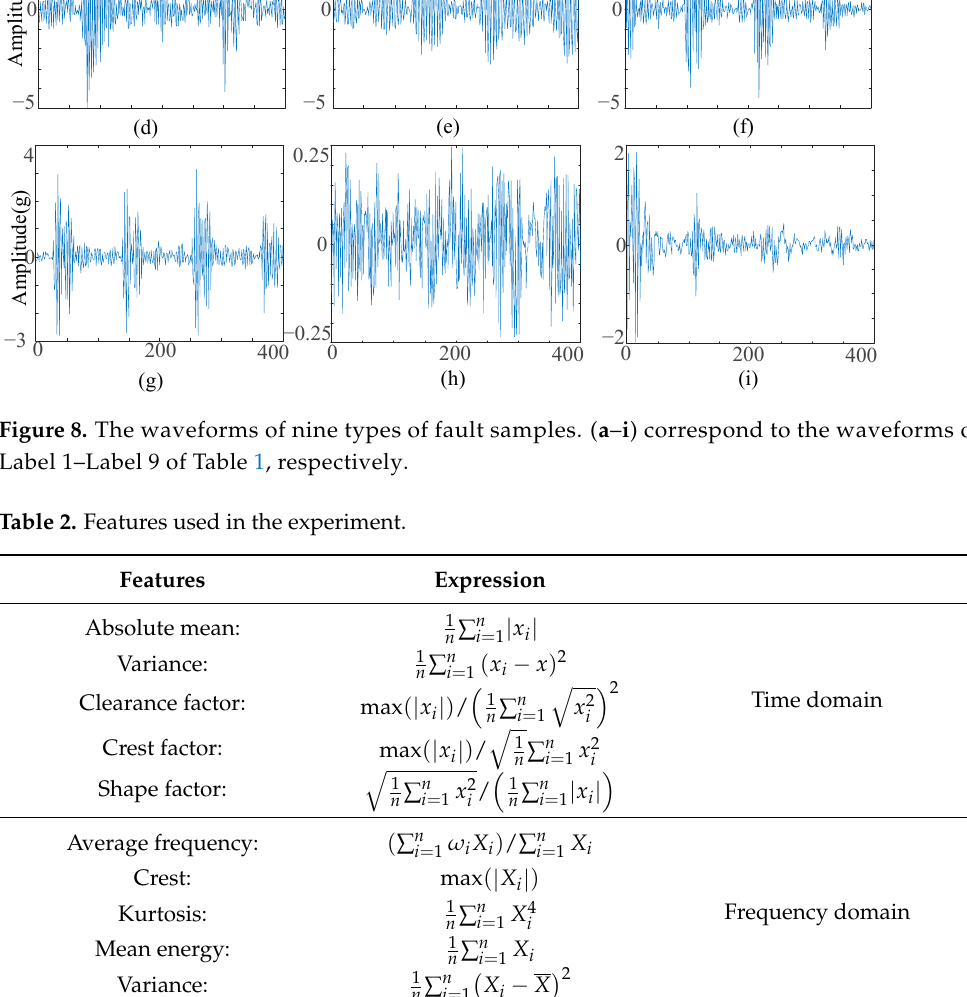
Table 2. Features used in the experiment.